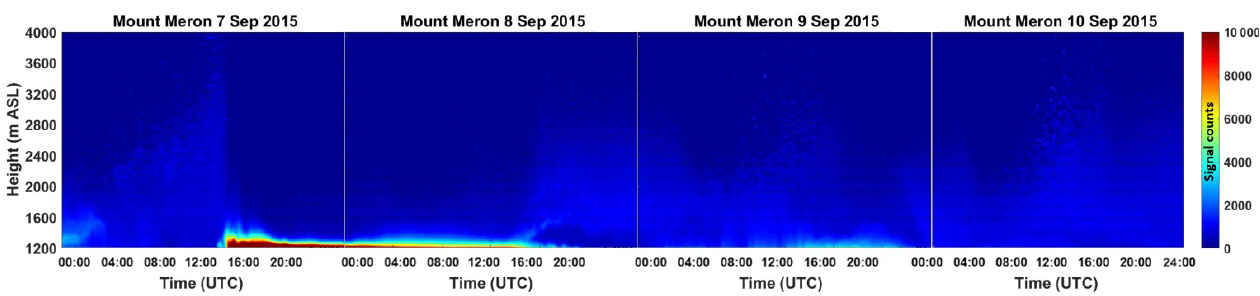
Figure 13. Mount Meron ceilometer signal counts plots for 7–10 September 2015. The y axis is the height from site deployment to 4000ma.s.l., the x axis is the time in UTC, and the signal count scale ranges between 0 and 10000.